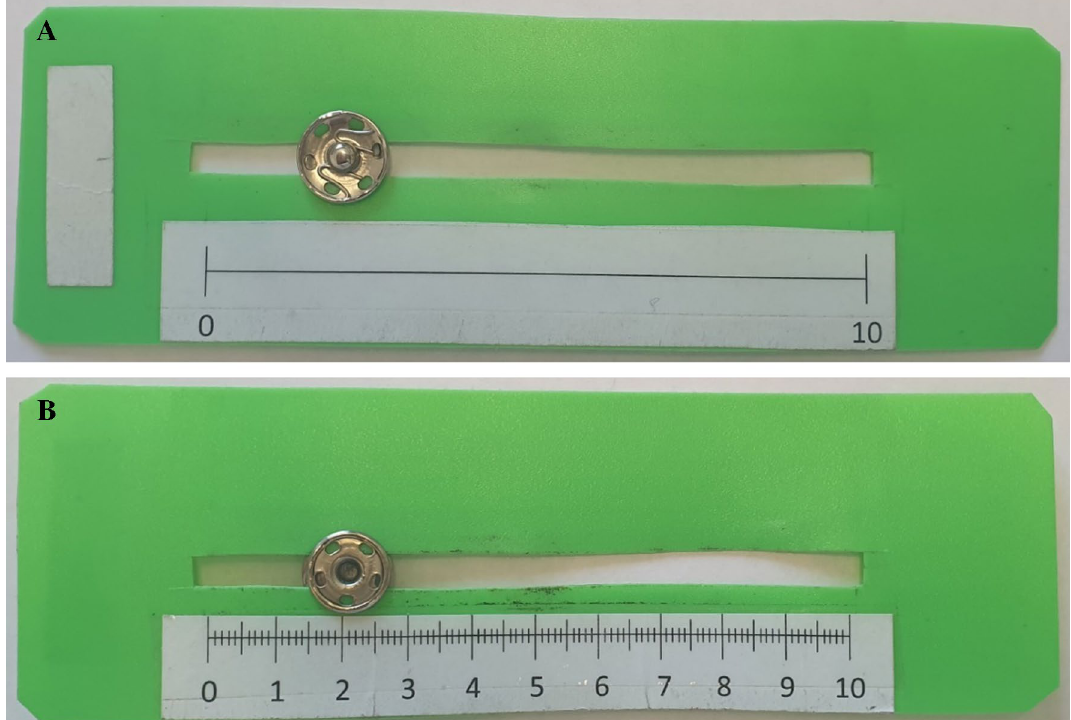
Figure 1. Slider. ( A ) Respondents view of the slider (front side). ( B ) Enumerator view of the slider (back